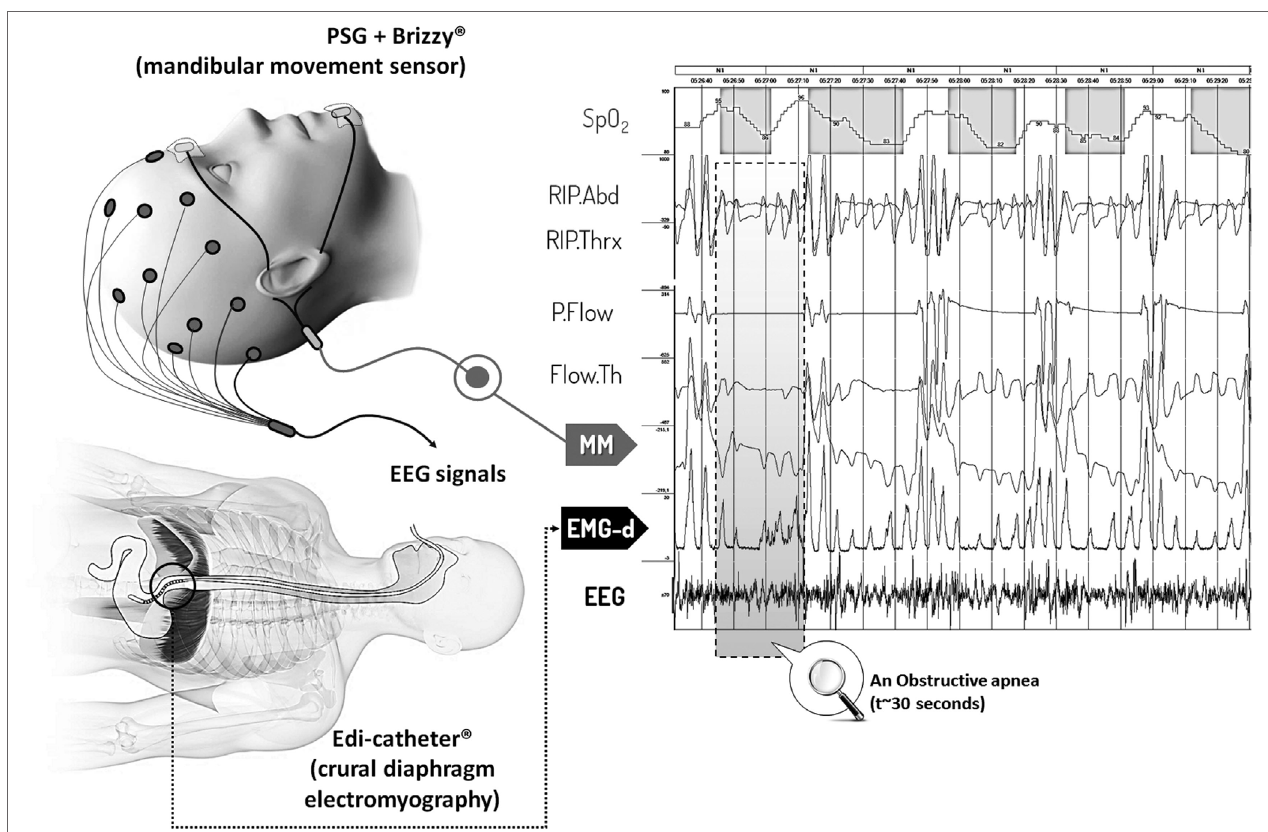
FigUre 1 | Polysomnographic 3 min segment including Mandibular movements and diaphragmatic electromyography (EMG-d) signals during episodes of obstructive apnea and hypopnea. Abbreviations: SpO 2 , oxygen saturation; RIP. Abd, RIP. Thx, abdominal and thoracic inductance belts; P. Flow, Flow. Th, nasal pressure transducer and oronasal thermal flow sensor; MM, mandibular movements; EMG-d, diaphragmatic electromyography; EEG, electro-encephalogram derived signal